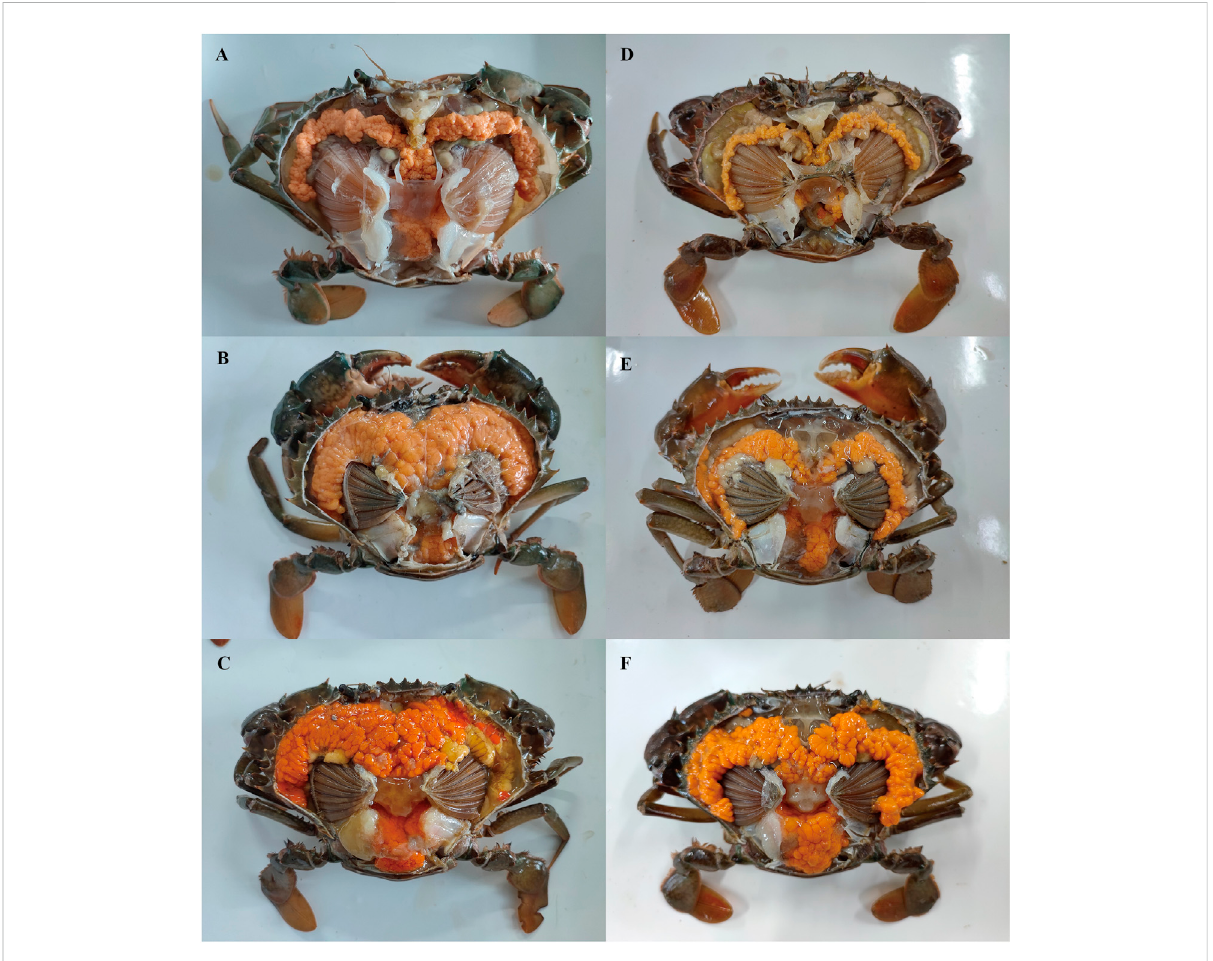
FIGURE 3 Externalobservation inovaryof Scyllaparamamosain during thetwovitellogenesisperiods. (A) :ovarian stage Ⅲ oftheFVP; (B) :ovarian stage Ⅳ of the FVP; (C) : ovarian stage Ⅴ of the FVP; (D) : ovarian stage Ⅲ of the SVP; (E) : ovarian stage Ⅳ of the SVP; (F) : ovarian stage Ⅴ of the SVP.